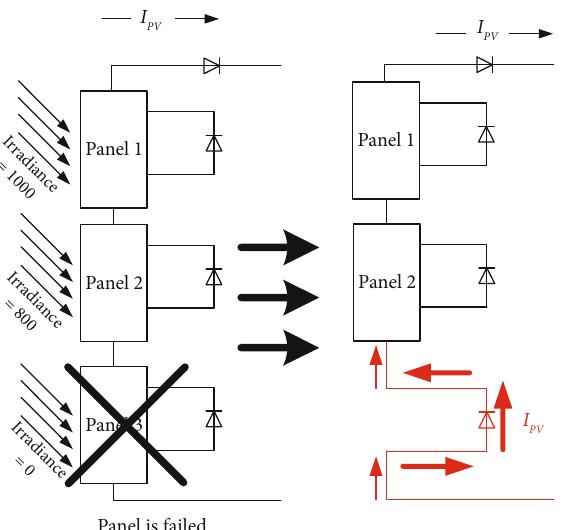
Figure 12: The third panel of PV1 is